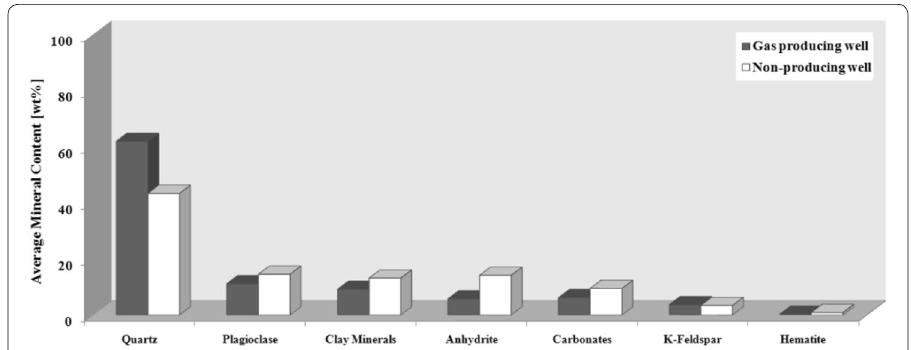
Fig. 2 The quantitative mineralogical data of the Shurijeh Formation from the XRD analysis